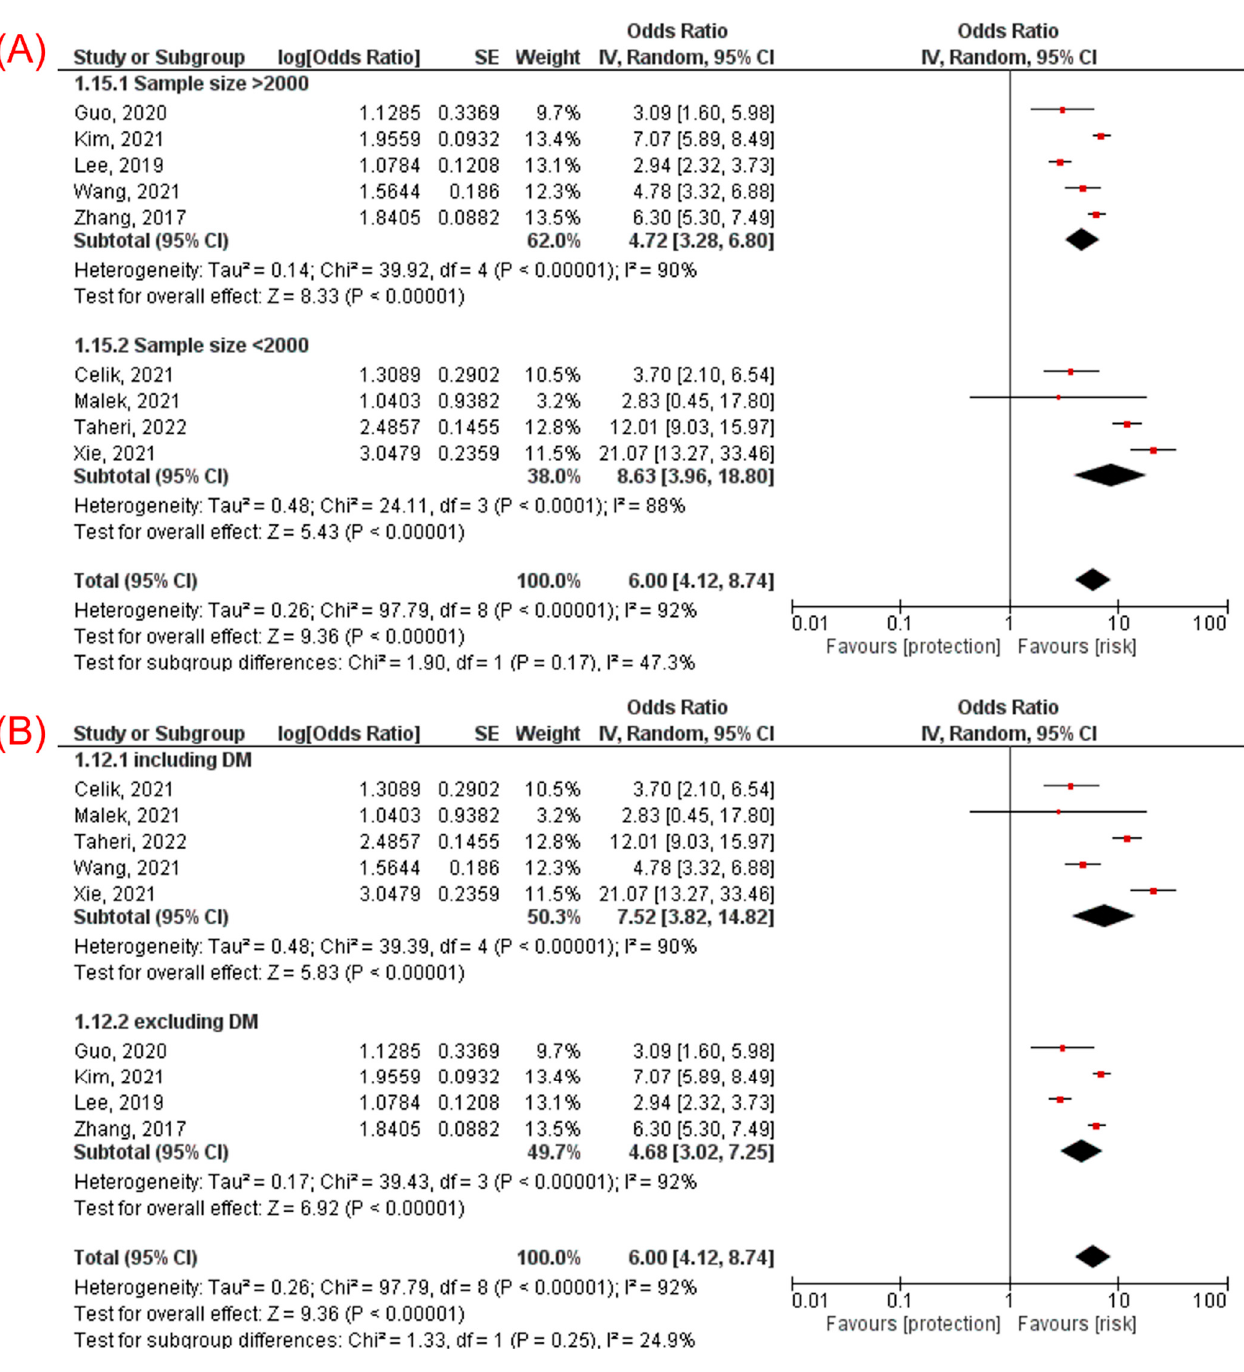
Figure 4. Subgroup analyses for the association between TyG index and NAFLD: ( A )